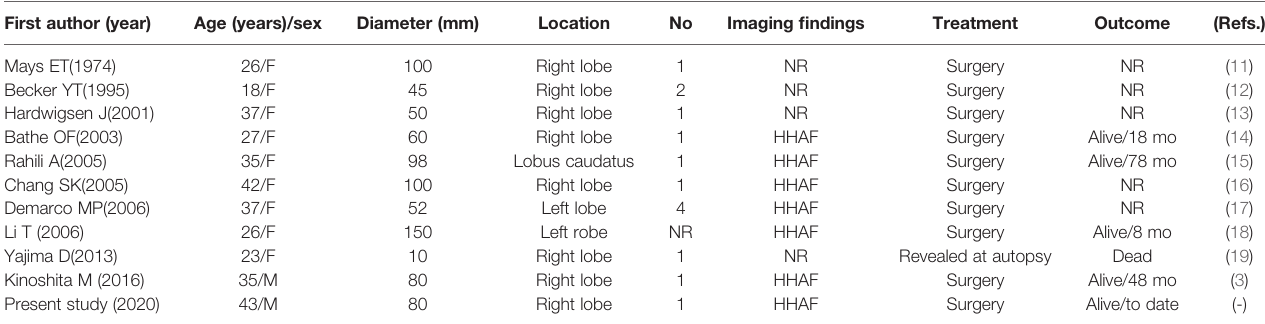
M, male; F, female; mo, months; No, number; HHAF, high-density hematoma area formed; NR, not reported.